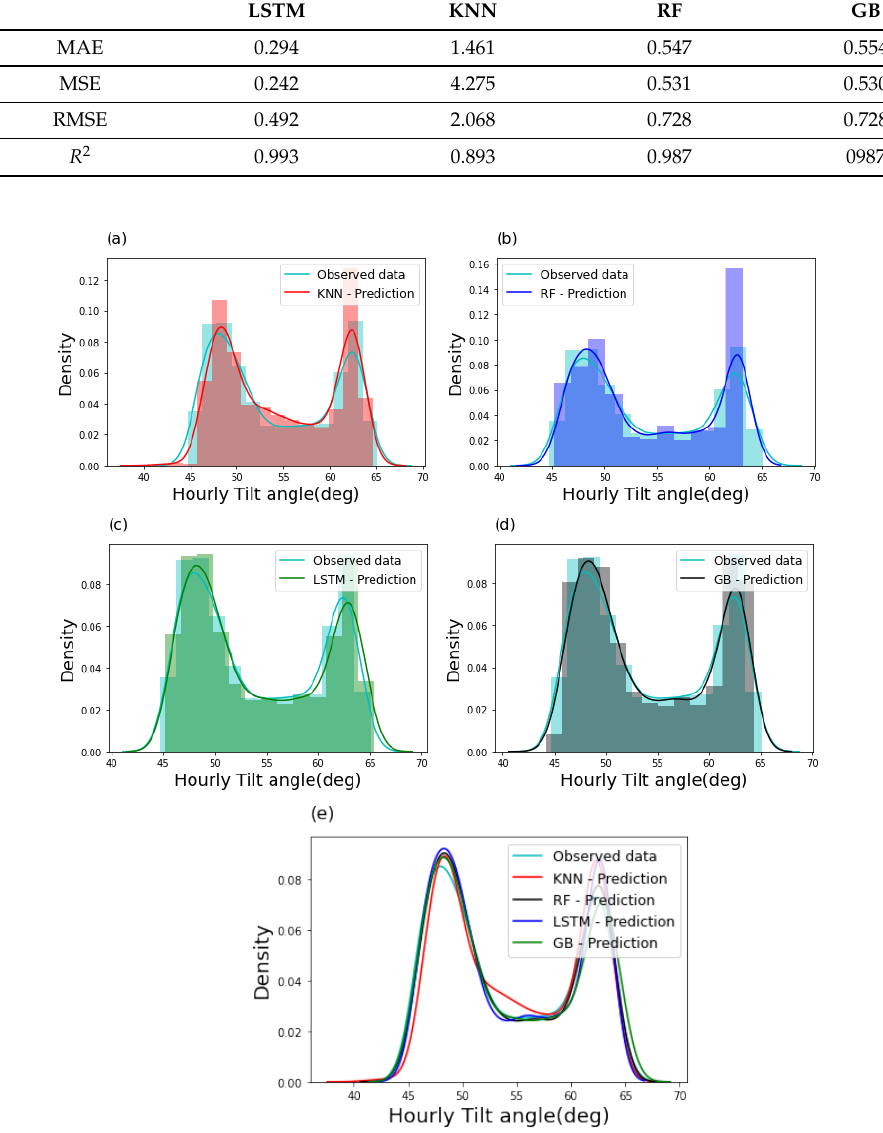
Figure 10. Probability density plots for ( a ) KNN, ( b ) RF, and ( c ) LSTM predictions, ( d ) GB predictions and their comparisons in ( e ), all plotted with hourly observed testing